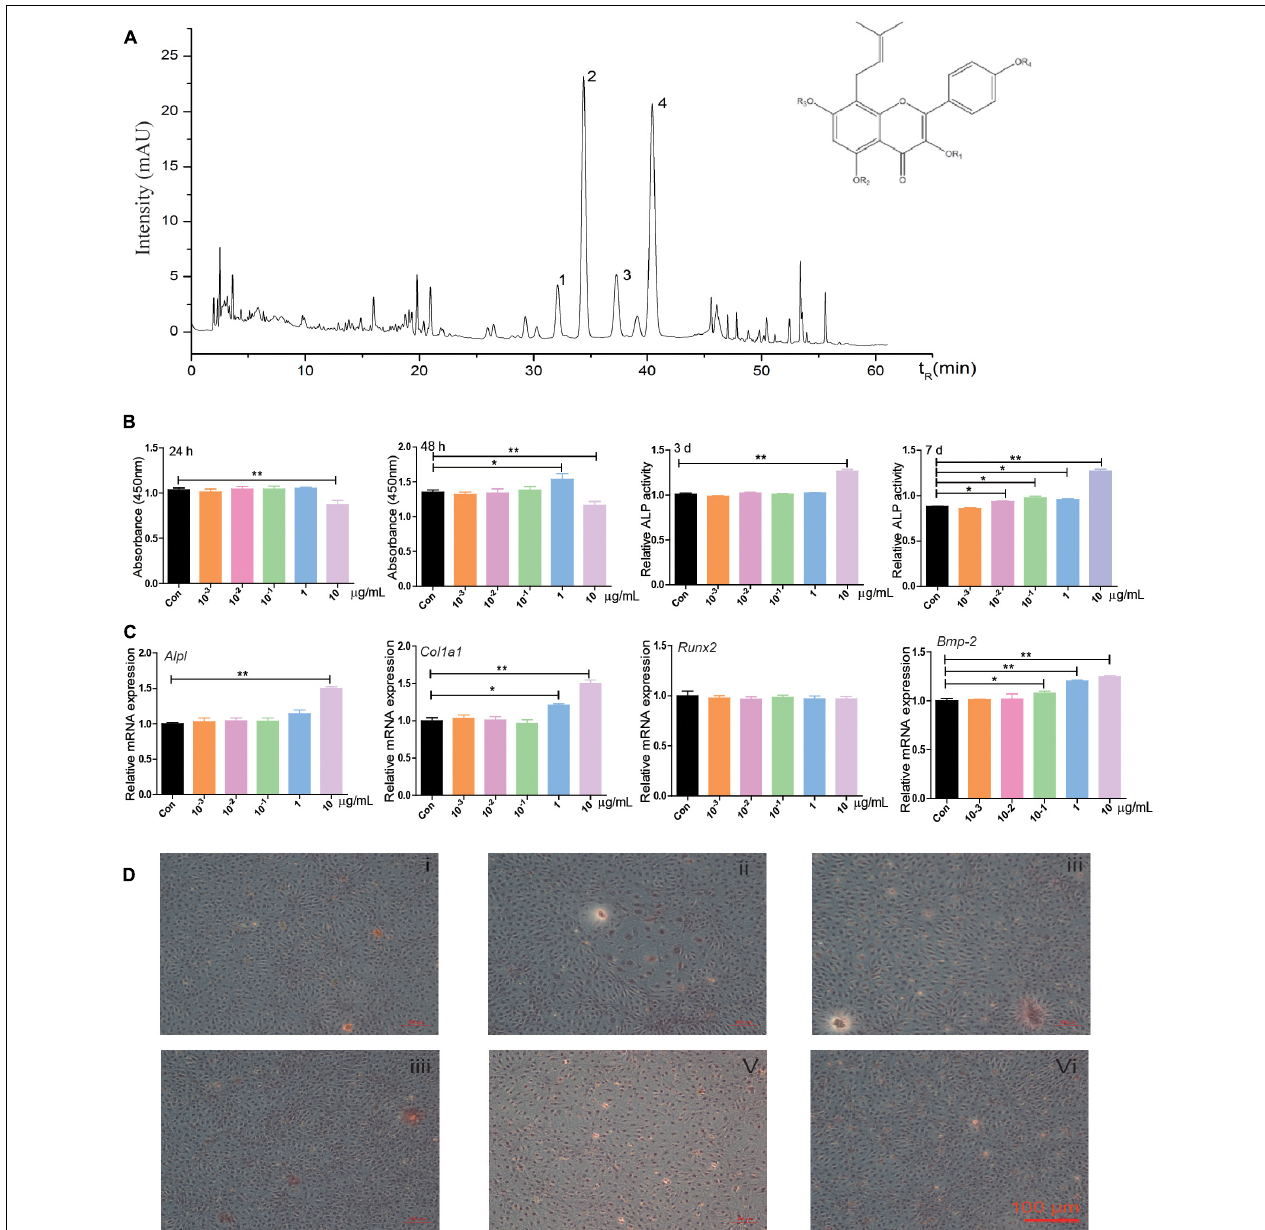
FIGURE 1 | The chemical composition of the water extract of EPI and its effects on proliferation and osteogenic differentiation in BMSCs. (A) The HPLC results showed that Epimedin A, Epimedin B, Icariin, and Epimedin C were identified in the water extract of EPI, 1: Epimedin A, 2: Epimedin B, 3: Icariin, 4: Epimedin C. (B) The effect of different EPI concentrations (10 − 3 , 10 − 2 , 10 − 1 , 1, and 10 µ g/ml) of EPI on BMSCs proliferation and osteogenic differentiation; the raw data represented mean ± SD. (C) The mRNA expression of osteogenic differentiation-related factors with different EPI concentrations (10 − 3 , 10 − 2 , 10 − 1 , 1, and 10 µ g/ml) of EPI. (D) Alizarin Red S staining of BMSCs with different concentrations (10 − 3 , 10 − 2 , 10 − 1 , 1, and 10 µ g/ml) of EPI; scale bar: 100 µ m. * p < 0.05, ** p < 0.01; analyses were done twice and obtained comparable results.